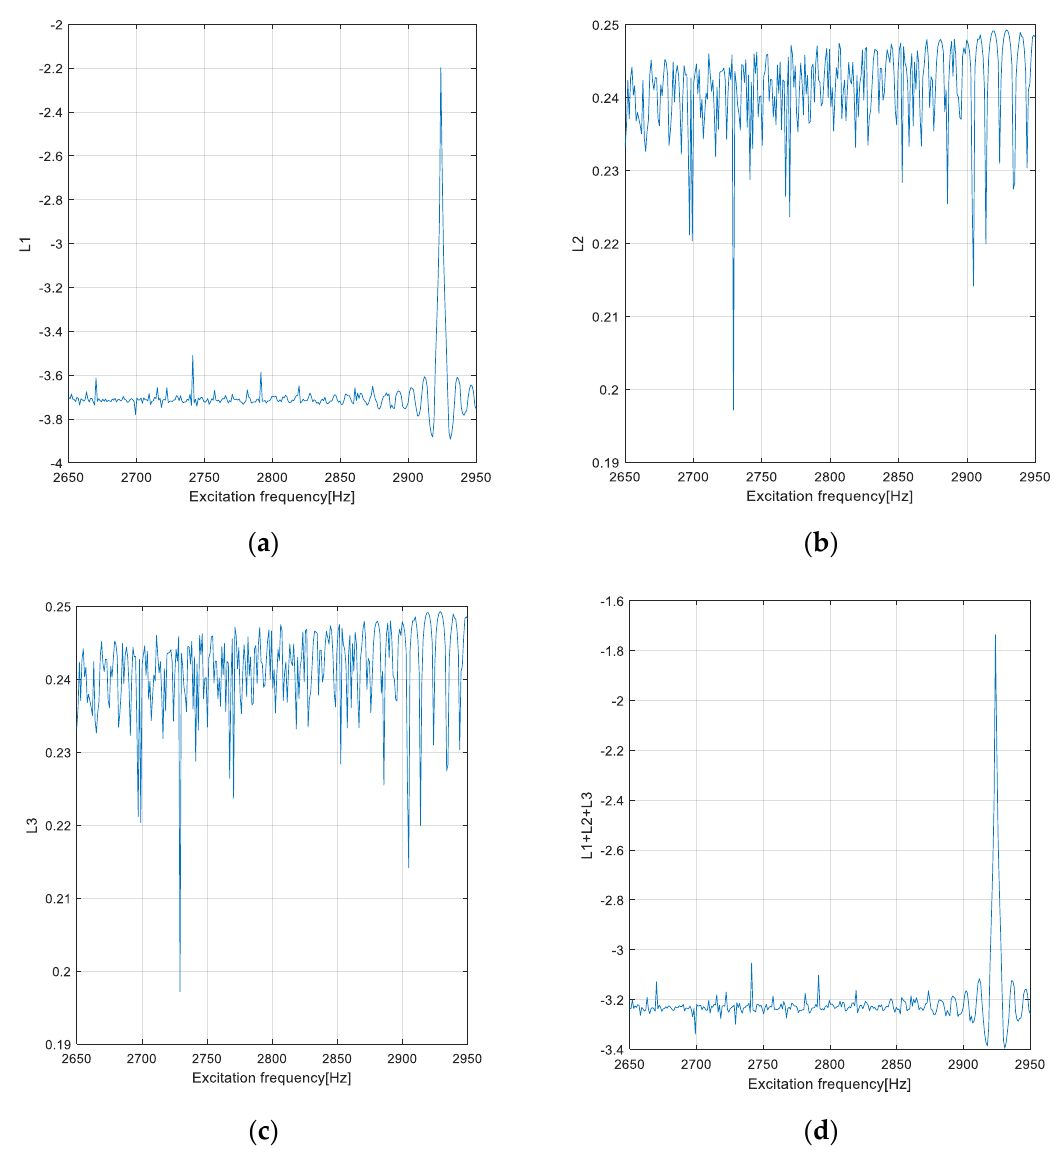
Figure 22. Lyapunov exponents of NFTV for DOE3, β